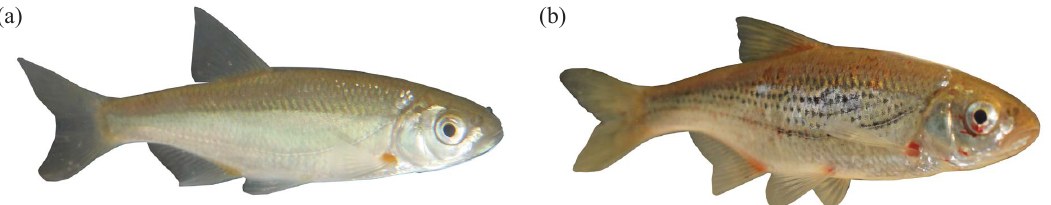
Figure 12. Injured spirlin ( Alburnoides bipunctatus ) which passed through the electrified horizontal bar rack with U e = 38 V and s b = 51 mm ( a ) before and ( b ) after the experiment.